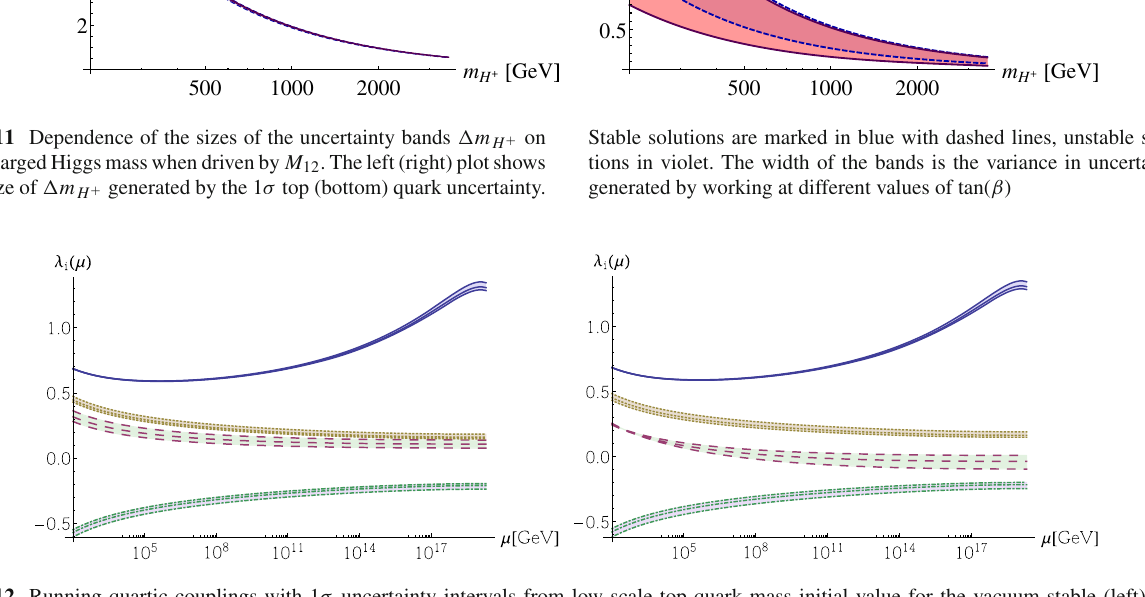
Fig. 12 Running quartic couplings with 1 σ uncertainty intervals from low scale top quark mass initial value for the vacuum-stable (left) and vacuum-unstable (right) fixed point branch. The colours correspond to: λ 1 (blue), λ 2 (violet, dashed), λ 3 (yellow, dotted) and λ 4 (green, dot-dashed)